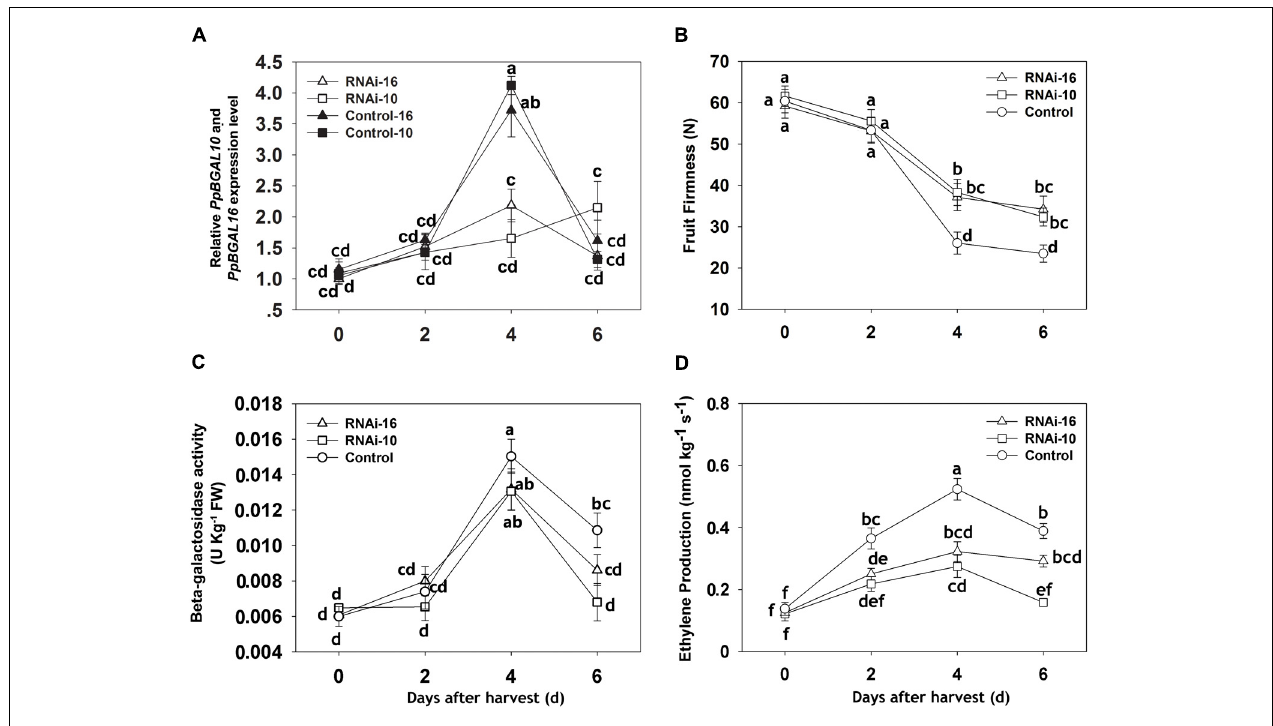
FIGURE 4 | Changes in the expression level of PpBGAL10 and PpBGAL16 , fruit firmness, β -gal activity, and ethylene production during storage of control (TRV2), RNAi-10 (TRV2- PpBGAL10 ), and RNAi-16 (TRV2- PpBGAL16 ) fruit. (A) Relative transcript abundance of PpBGAL10 and PpBGAL16 , RNAi-10, RNAi-16 and Control-10, Control-16 represents expression of PpBGAL10 and PpBGAL16 in RNAi and Control fruit, respectively, (B) fruit firmness, (C) β -gal activity, and (D) ethylene production RT-qPCR expression levels were normalized using the cycle threshold value of the peach 18S rRNA gene. Data represent the mean ± SE ( n = 3). Significant differences ( p < 0.05) between means are indicated by different